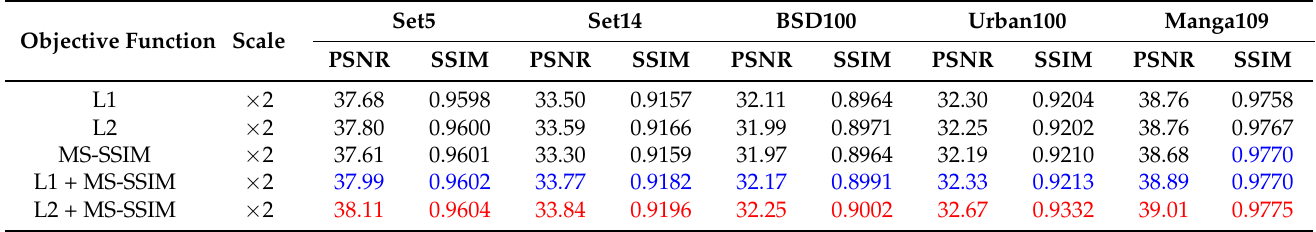
Table 2. Quantitative performance comparison among different objective functions at × 2 scale.